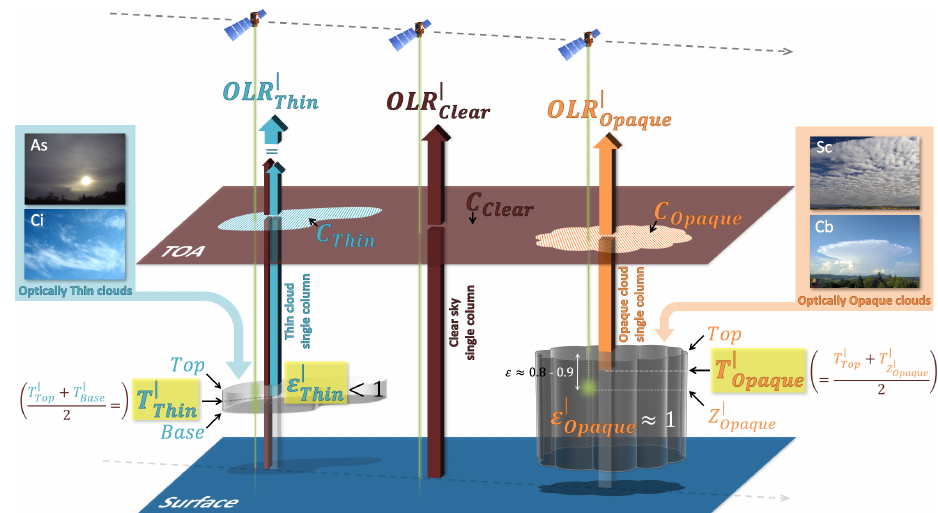
Figure 1. Partitioning of the atmosphere into three single column types thanks to the CALIOP lidar: (left) thin-cloud single column, when a cloud is detected in the lidar signal and the laser beam reaches the surface, (middle) clear-sky single column, when no cloud is detected, and (right) opaque-cloud single column, when a cloud is detected and the laser beam becomes fully attenuated at a level called Z C , T , and ε account for cover, temperature, and emissivity. Variables highlighted in yellow are the key cloud properties, extracted from GOCCP–OPAQ, that drive OLR over thin-cloud and opaque-cloud single columns. The total gridded OLR will be computed from the three single column OLRs weighted by their respective cover: C thin , C clear , C opaque